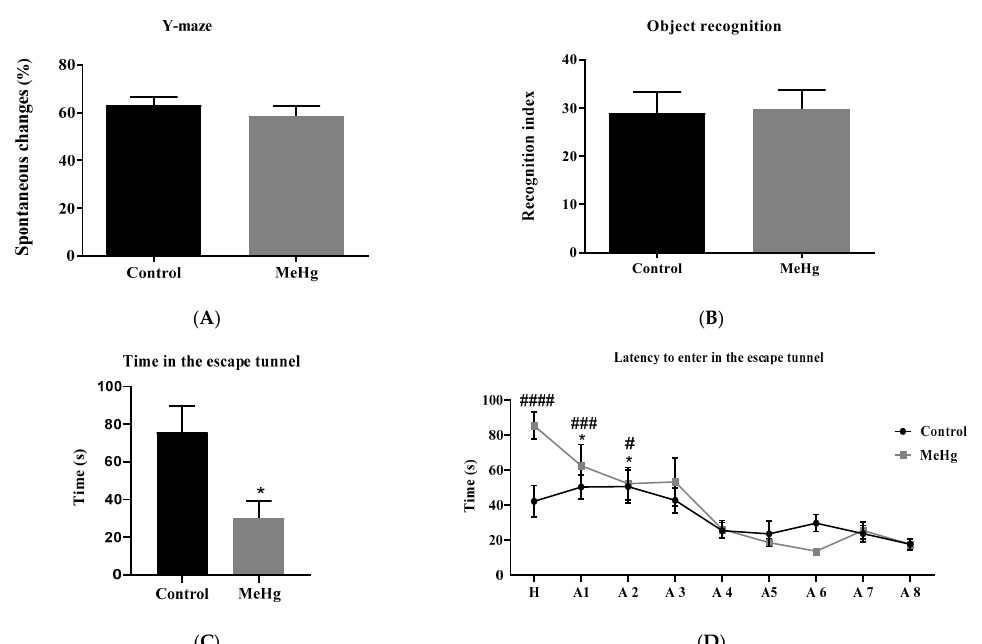
Figure 6. Memory behavior assessment. Effect of oral administration of MeHg (2 mg/L) over 30 days on mouse behavior using ( A ) Y-maze and ( B ) object recognition test. Values are expressed as mean ± SEM, n = 10 per group. unpaired Student t -test. Effect of oral administration of MeHg (2 mg/L) over 30 days on mouse memory using the Barnes maze ( C,D ). Values are expressed as the mean ± SEM, n = 10 per group. * p < 0.05 vs. control ( C ). * p < 0.05, vs. A8 control. # p < 0.05, ### p < 0.001, #### p < 0.0001 vs. A8 MeHg by two-way ANOVA (D) . H = Habituation, A = Acquisition, P = Probe.